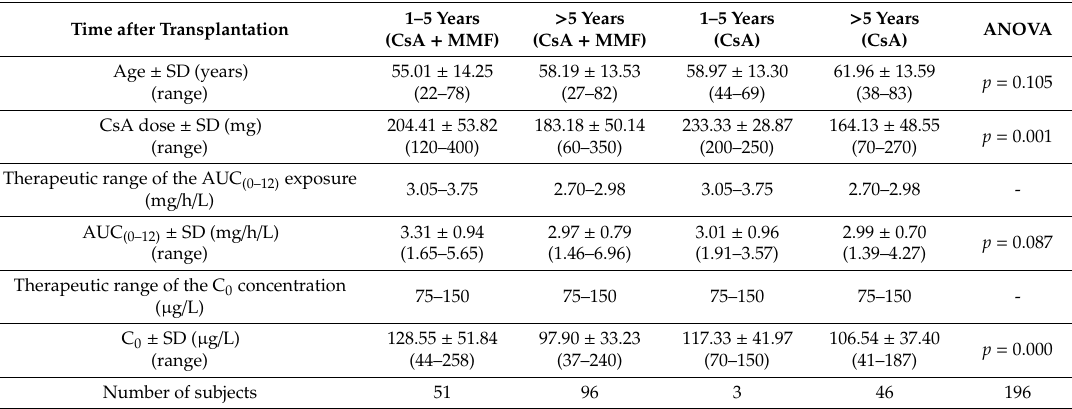
Table 5. Baseline data of cyclosporine-receiving